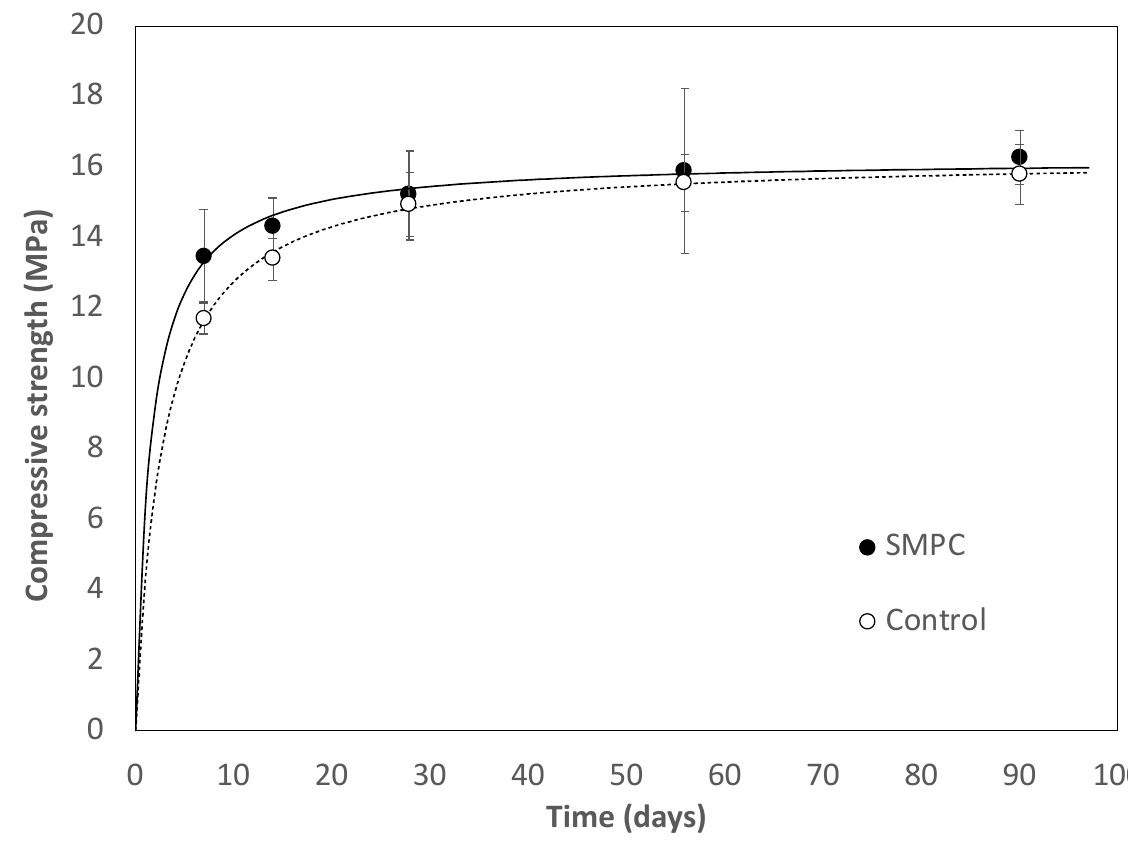
Figure 2. Development of compressive strength.